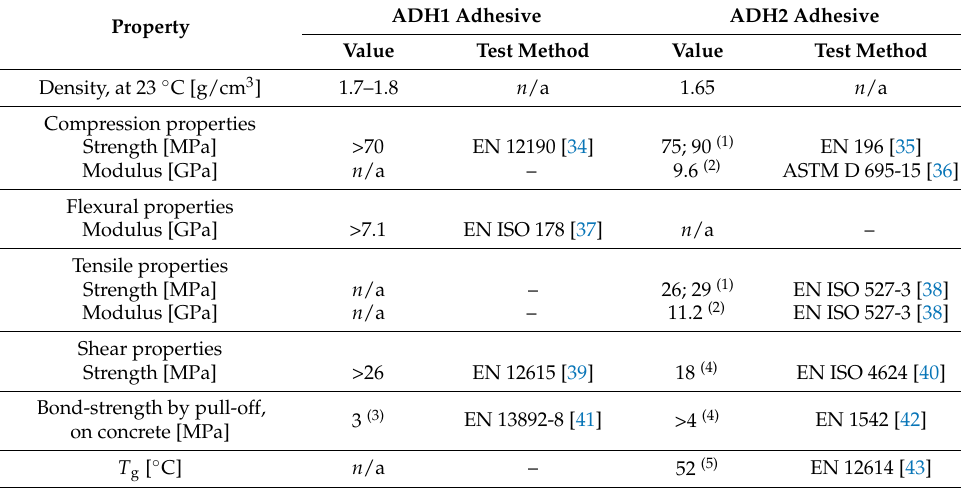
Table 1. Adhesives